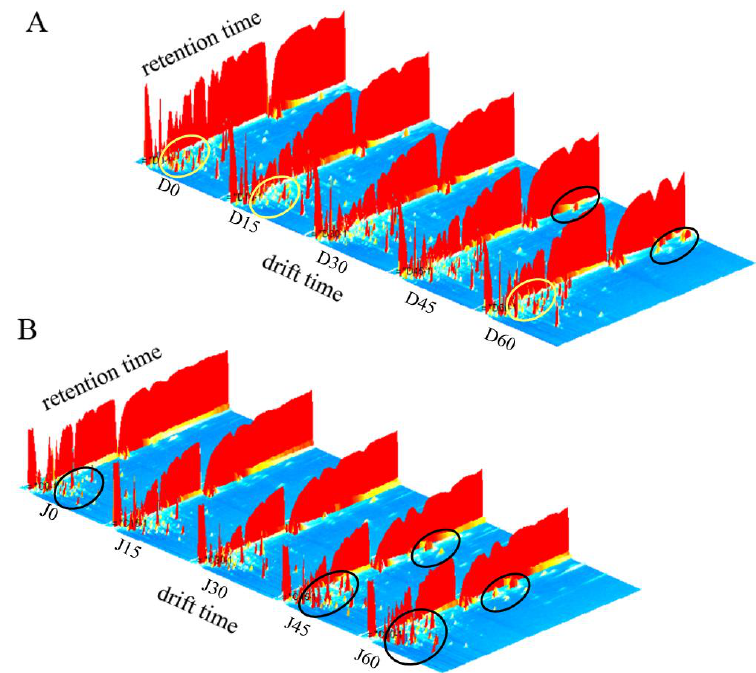
Figure 2. 3D-topographic plots of jujube fruits at di ff erent times. Jujube fruits are Dongzao shown in ( A ), D0, D15, D30, D45, and D60 represent refrigeration for 0, 15, 30, 45, and 60 days, respectively. Jujube fruits are Jinsixiaozao shown in ( B ), J0, J15, J30, J45, and J60 represent refrigeration for 0, 15, 30, 45, and 60 days, respectively.